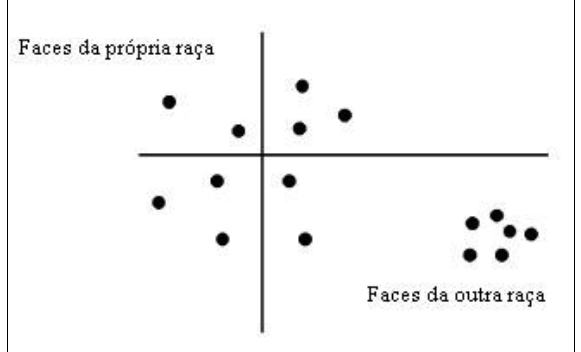
Figura 2 . Representação esquemática para faces da mesma raça e faces de outra raça dentro do Espaço Multidimensional. A Figura 2 representa um esquema bidimensional ilustrativo, quando na realidade o espaço é formado por múltiplas